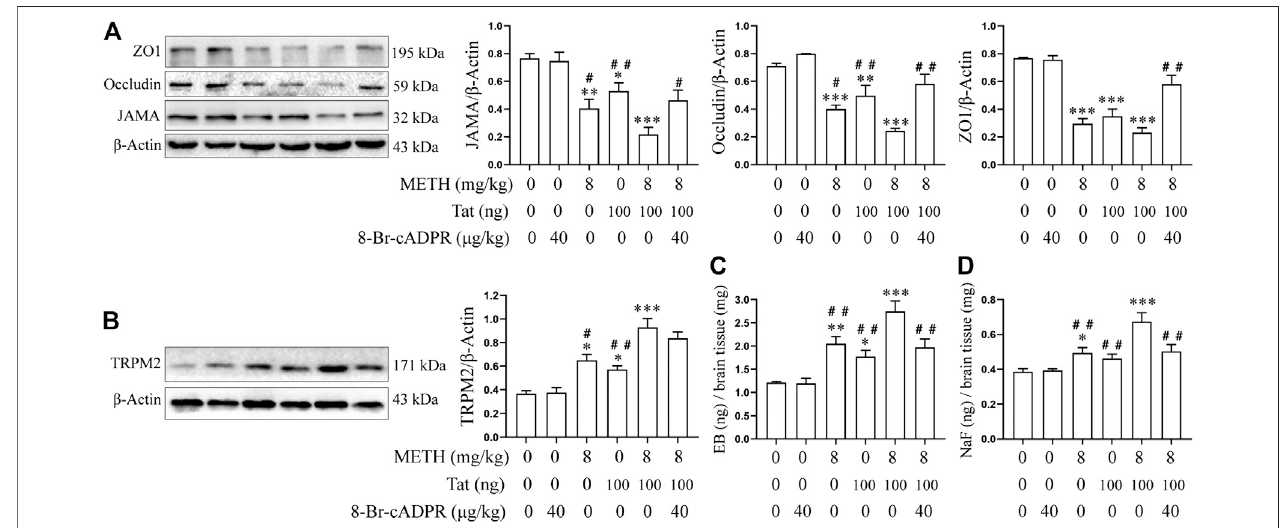
FIGURE9| 8-Br-cADPRattenuatessynergisticMETH-andHIV-Tat-inducedBBBdamageintreeshrews.AlltheanimalsweretreatedwithMETHand/orHIV-Tatwith orwithouttheinterventionof8-Br-cADPRfor10consecutivedaysbytheaboveadministrationregimen,theneuthanized24 hafterthelasttreatment.Sixtreeshrewsineach groupweretreatedwithEBorNaFbytailintravenousinjection1 hbeforetheendofthelasttreatment. (A,B) WesternblotwasperformedtodetermineJAMA,Occludin,ZO1, and TRPM2 expression levels in the prefrontal cortex of the tree shrews; (C) EB and (D) NaF quantitative analyses in a whole-brain context were used to detect the permeability of BBB. Compared with the control, * p < 0.05, ** p < 0.01, *** p < 0.001; compared with the METH + HIV-Tat, # p < 0.05, ## p < 0.01, n (cid:1)